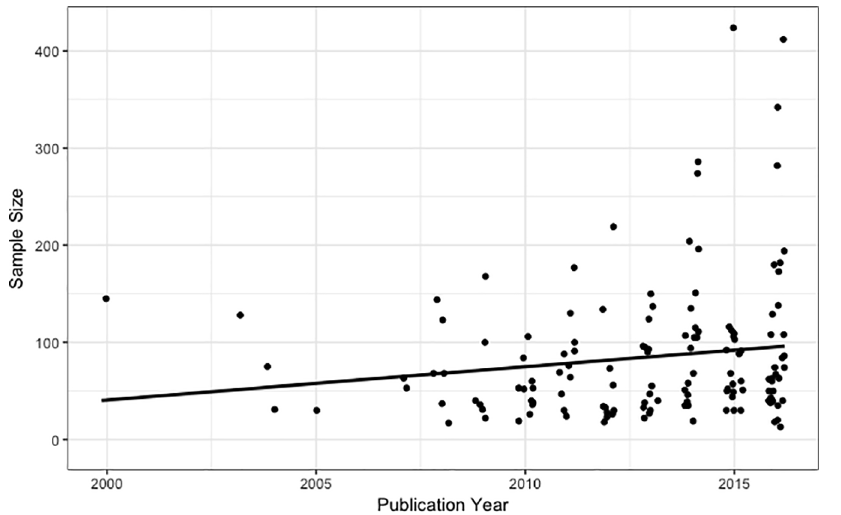
Fig 3. Changes in sample size over